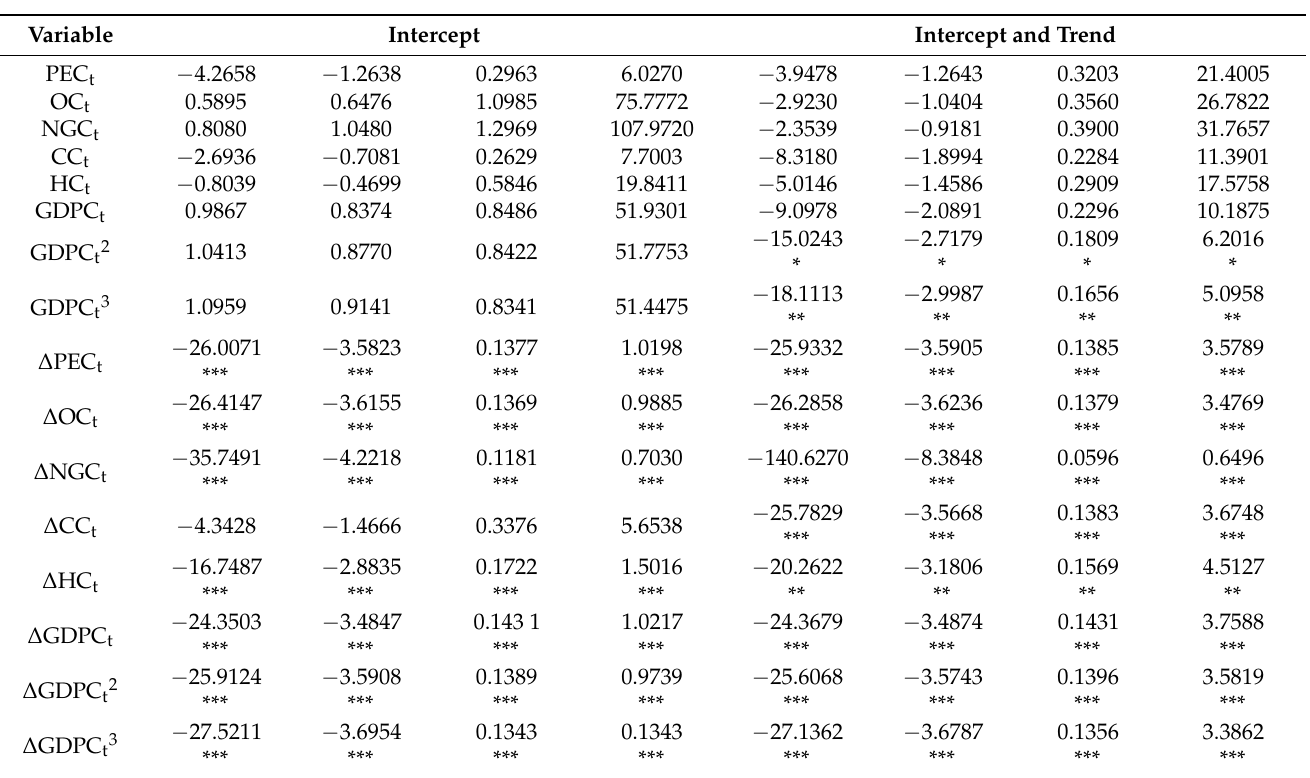
Table 2. Unit root